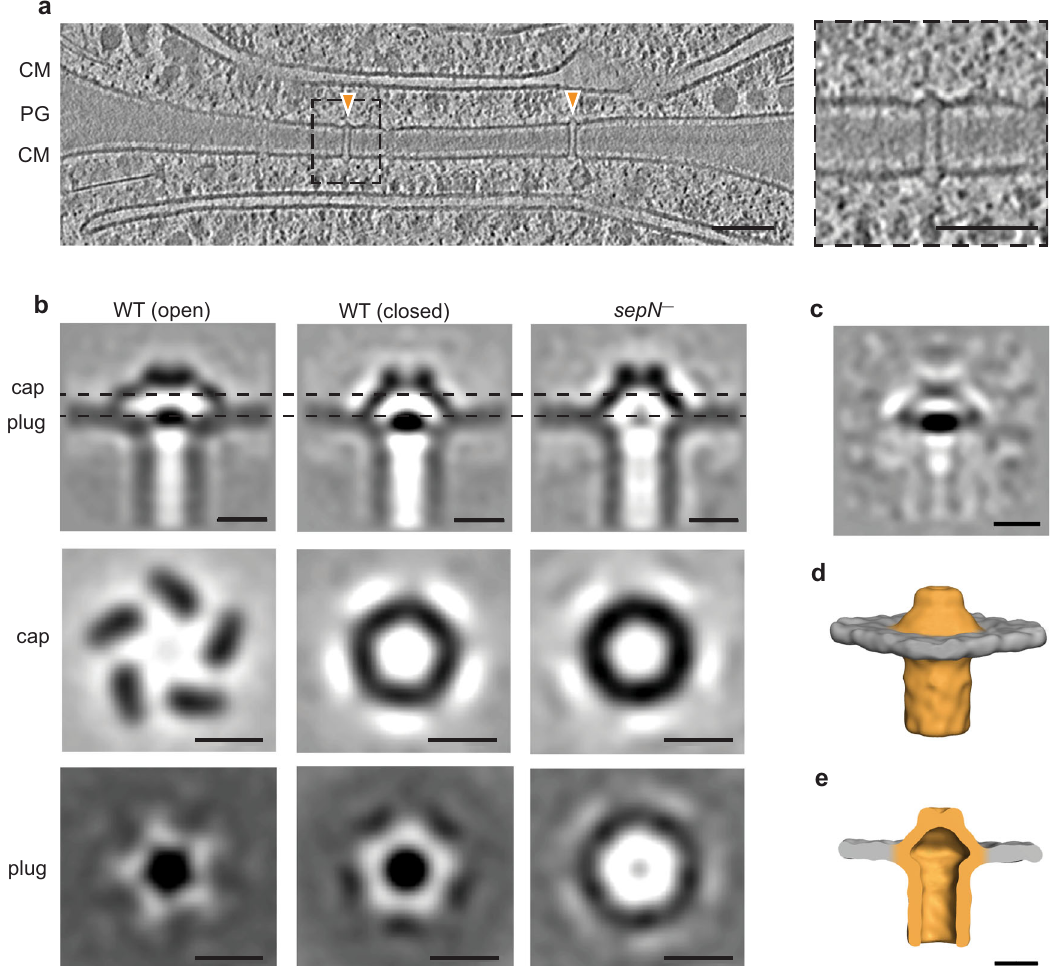
Fig. 5 | sepN − mutant is lacking the plug module. a Cryo-tomogram of the septal region(shown isa 13.5nm-thickslice)ofa sepN − mutant fi lamentwithtwo septum- spanning SJs (orange arrowheads). While cap and tube modules were still present, the plug module was absent in all observed SJs ( n =18 tomograms from 3 inde- pendent datasets of biological replicates). The dashed box indicates a magni fi ed view on the right. CM, cytoplasmic membrane; PG, septal peptidoglycan. Bars, 50nm. b Subtomogram averages of SJs from sepN − mutant (right) and WT in open (left) and closed state (middle). In the sepN − mutant, the plug was absent, and the cap resembled the closed state of WT SJs (middle). Shown are longitudinal and cross-sectional slices (0.68nm) through the averages. Sliced positions (cap and plug) are indicated by dashed lines. For the initial averages, 418 (from 22